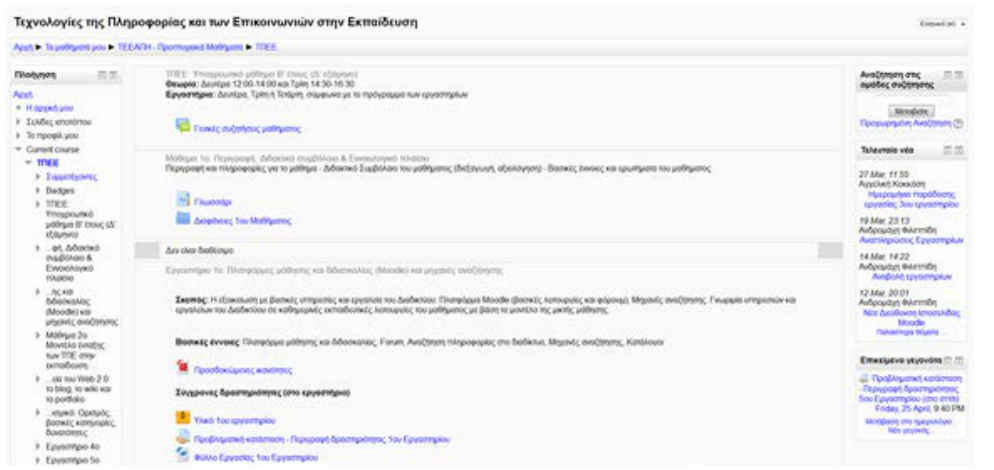
Figure 1 . The Moodle-based system for the course “Technologies of Information and Communication in Education” (tenth